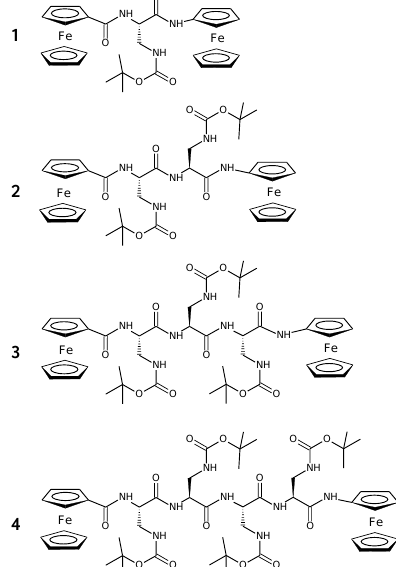
Figure 1. Chemical structures of bis-ferrocenyl end-capped peptides ( 1 – 4 ) of the amino acid (Dap) Fc – CO – [ L -Dap(Boc)] n – NH – Fc ( n = 1 – 4).